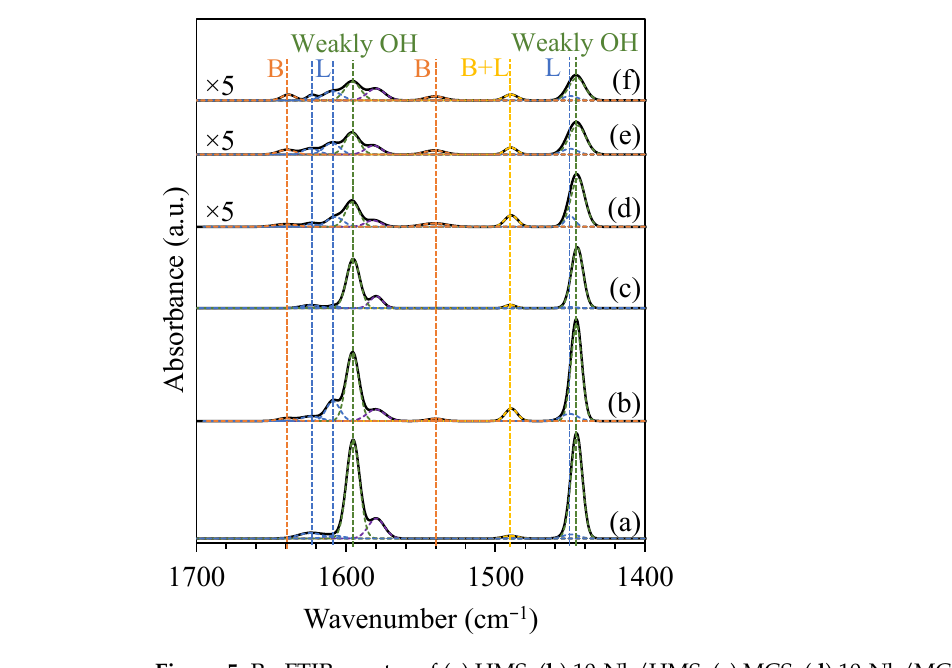
Figure 5. Py-FTIR spectra of ( a ) HMS, ( b ) 10-Nb/HMS, ( c ) MCS, ( d ) 10-Nb/MCS, ( e ) 20-Nb/MCS, and ( f ) 30-Nb/MCS catalysts.